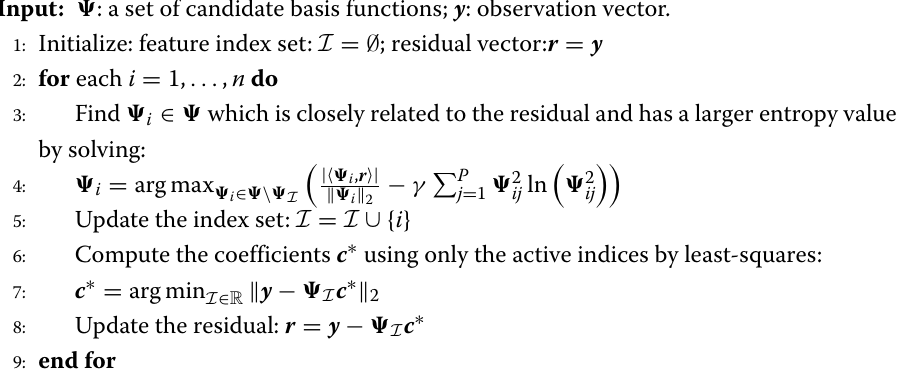
Algorithm 2 Hybrid entropy-based orthogonal matching pursuit